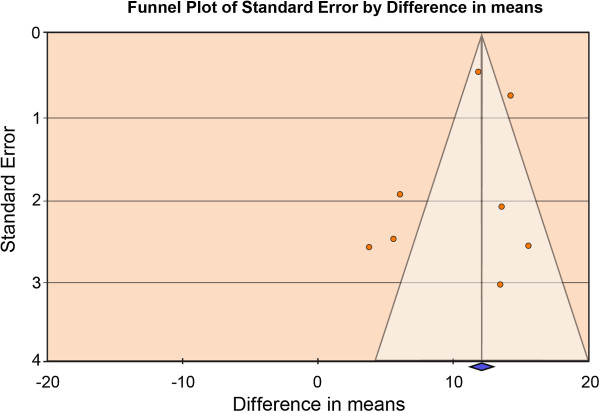
Visual Assessment of Publication Bias Using a Funnel Plot (SIGH-SAD composite scores). *A clustering indicative of publication bias around the mean treatment effect was not observed (i.e., no marked asymmetry was evident). In the absence of publication bias we would expect the studies to be distributed symmetrically about the combined treatment effect.